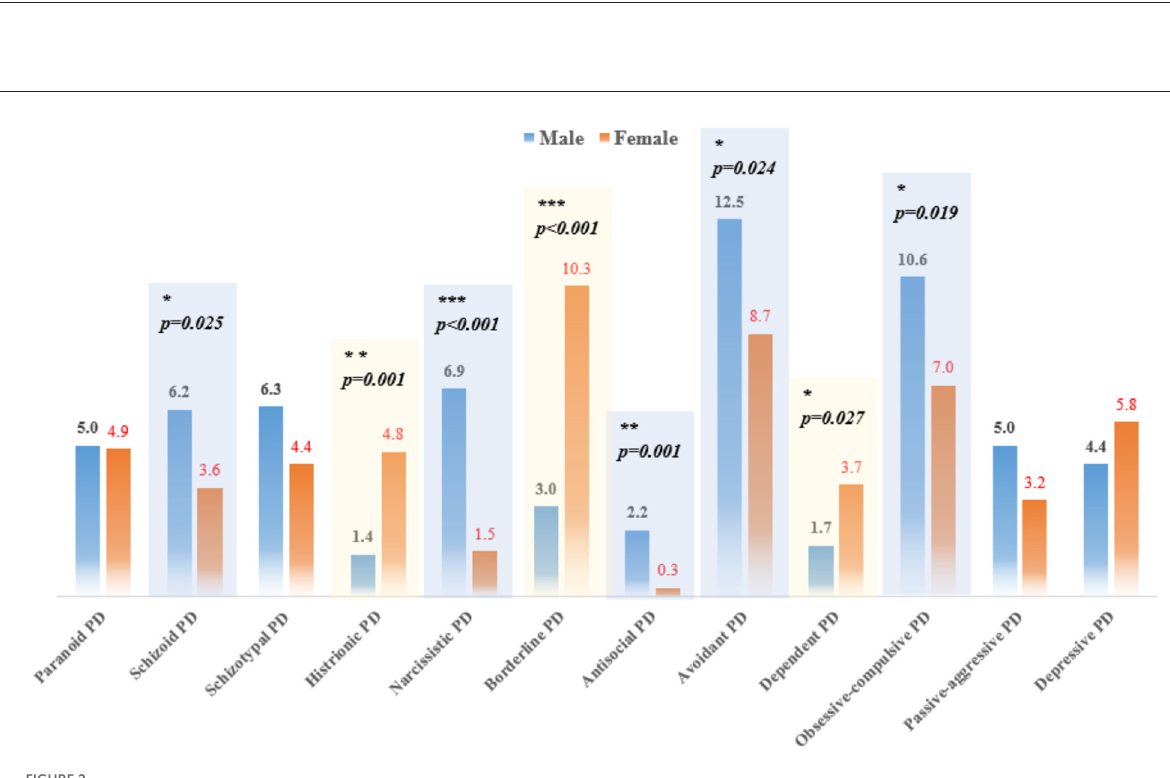
FIGURE2 Prevalence of SCID-II diagnosed PDs among patients with psychotic and non-psychotic